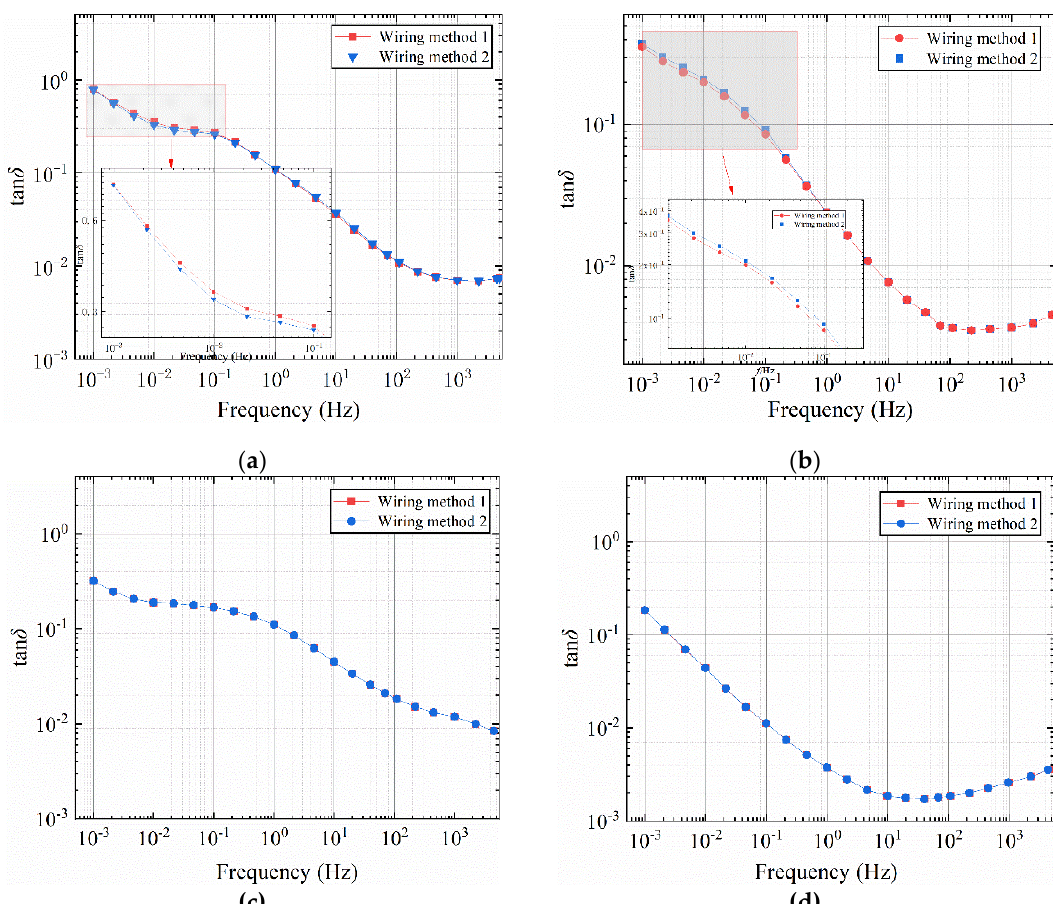
Figure 9. Effect of different wiring methods on tan δ - f curve of bushing model. ( a ) 1 # bushing model, ( b ) 2 # bushing model, ( c ) 3 # bushing model, ( d ) 4 # bushing model.